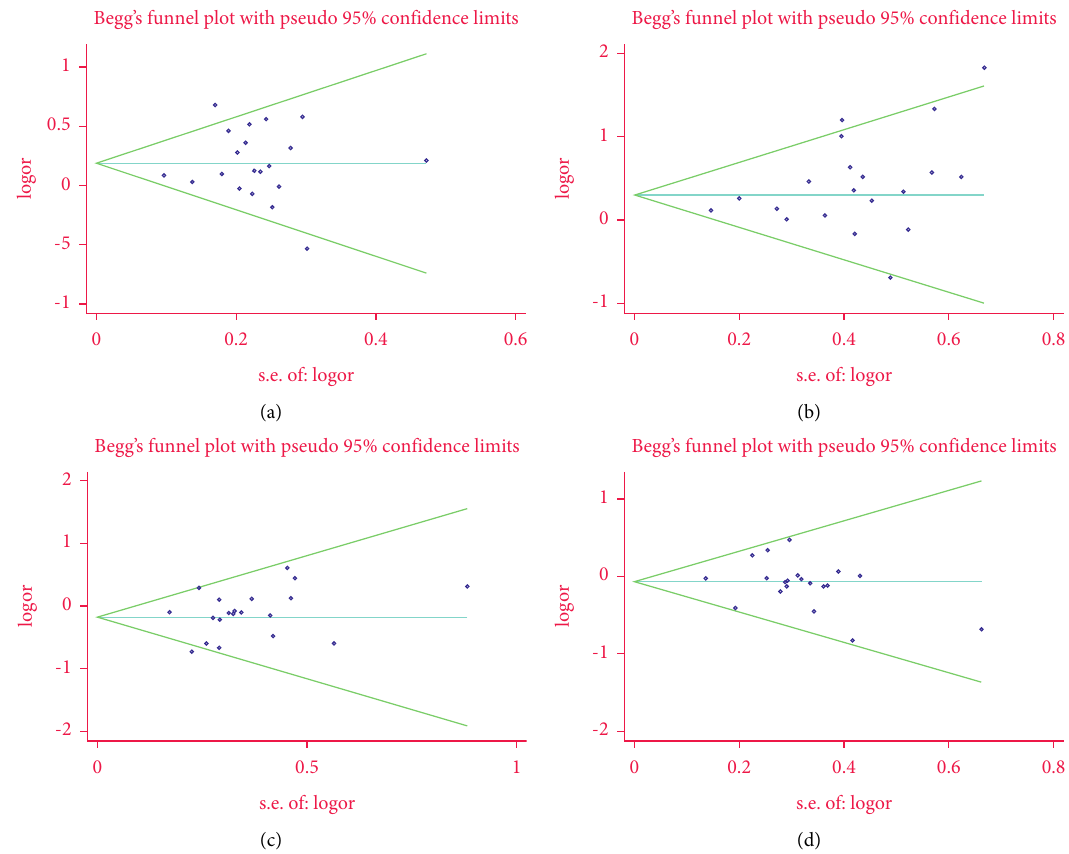
Figure 5: The funnel plots of different pooled analysis models. (a) Allele D vs. allele I; (b) genotype DD vs. genotype ID+ II; (c) genotype II vs. genotype DD +ID; and (d) genotype ID vs. genotype DD+